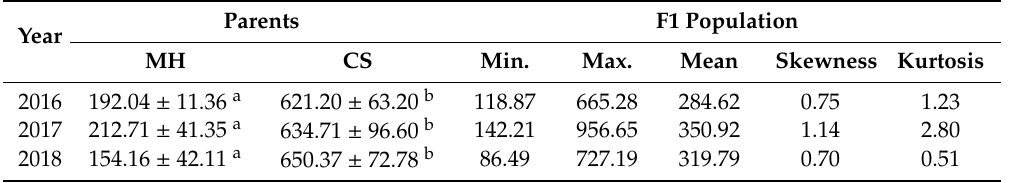
Table 1. Descriptive statistics of berry firmness for the parents and the F1 population.